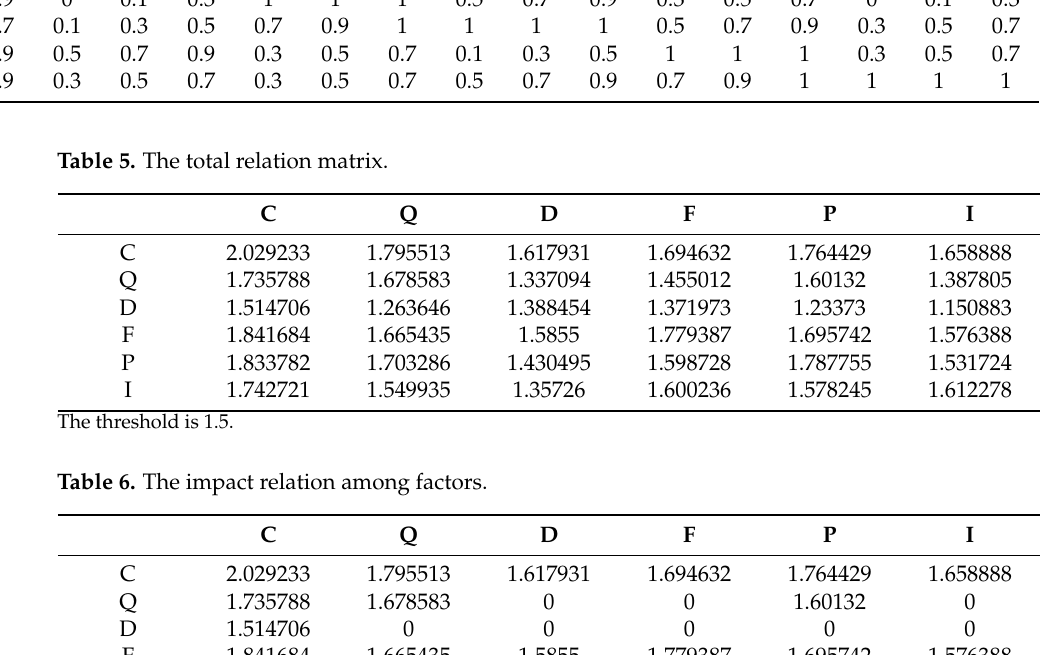
Table 5. The total relation matrix.